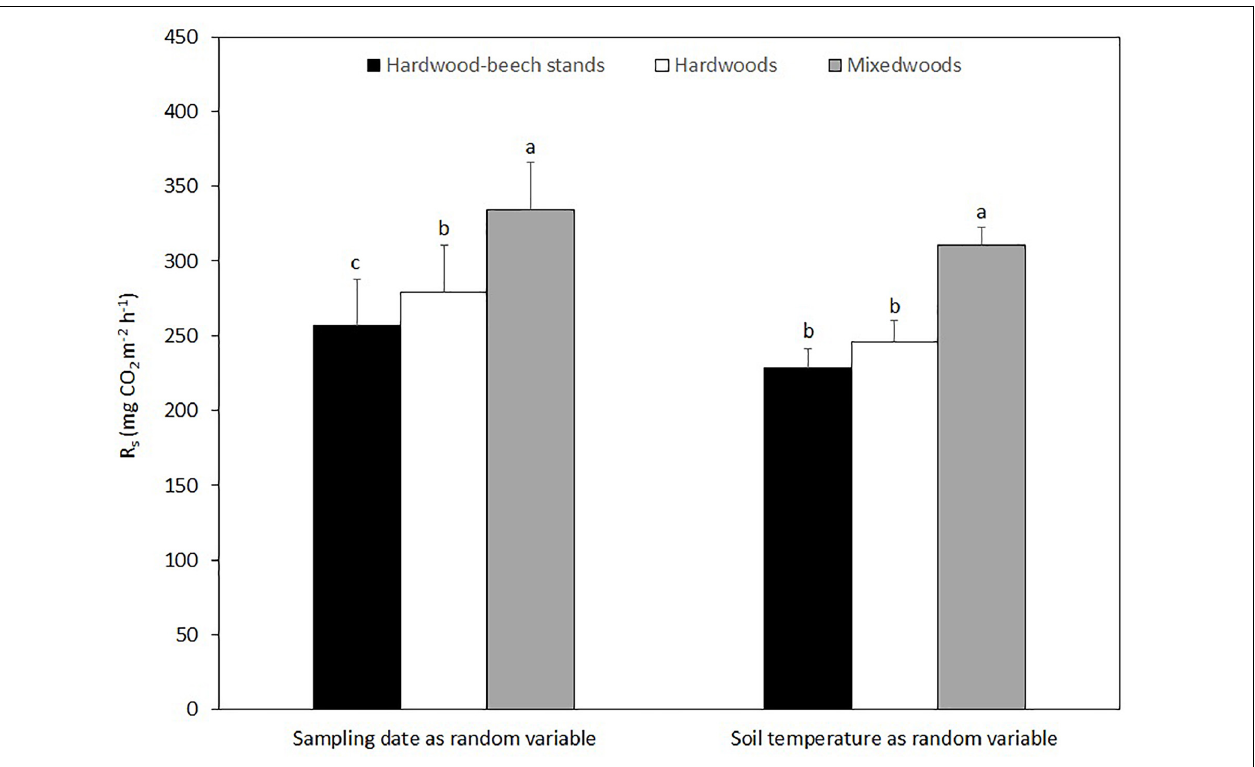
FIGURE 4 | Mean soil respiration rates (R s ) predicted from the linear mixed effect models for each forest type using sampling date and soil temperature as the random variables. Predicted values were back-transformed as a square root transformation was used in both models to assure normality of the residuals. Standard errors are shown. Different letters indicate a significant difference at P < 0.01 between forest types using the Tukey’s honest significant difference test. TABLE 5 | Root (R root ) and heterotrophic (R h ) respiration fluxes from the root exclusion plots in summer 2020. Forest